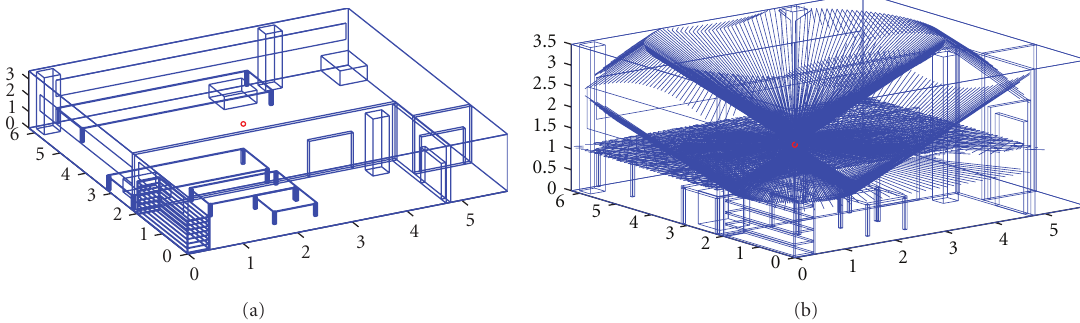
Figure 7: (a) R&D building’s laboratory no. 5, proposed for deterministic radio channel simulation. (b) Ray launching representation for the indoor scenario. Rays are launched given the solid angle definition within the simulation parameters.